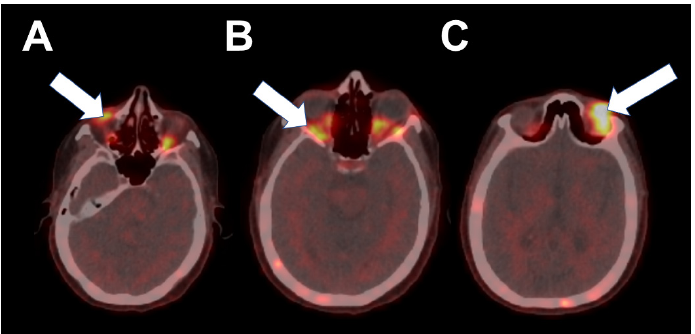
Figure 3. Fused axial PET/CT images demonstrate intense 18F-FES activity in soft tissue in the right inferior ( A , arrow) and left superior ( C , arrow) orbits and abnormally increased activity in bilateral extraocular muscles ( B , arrow).